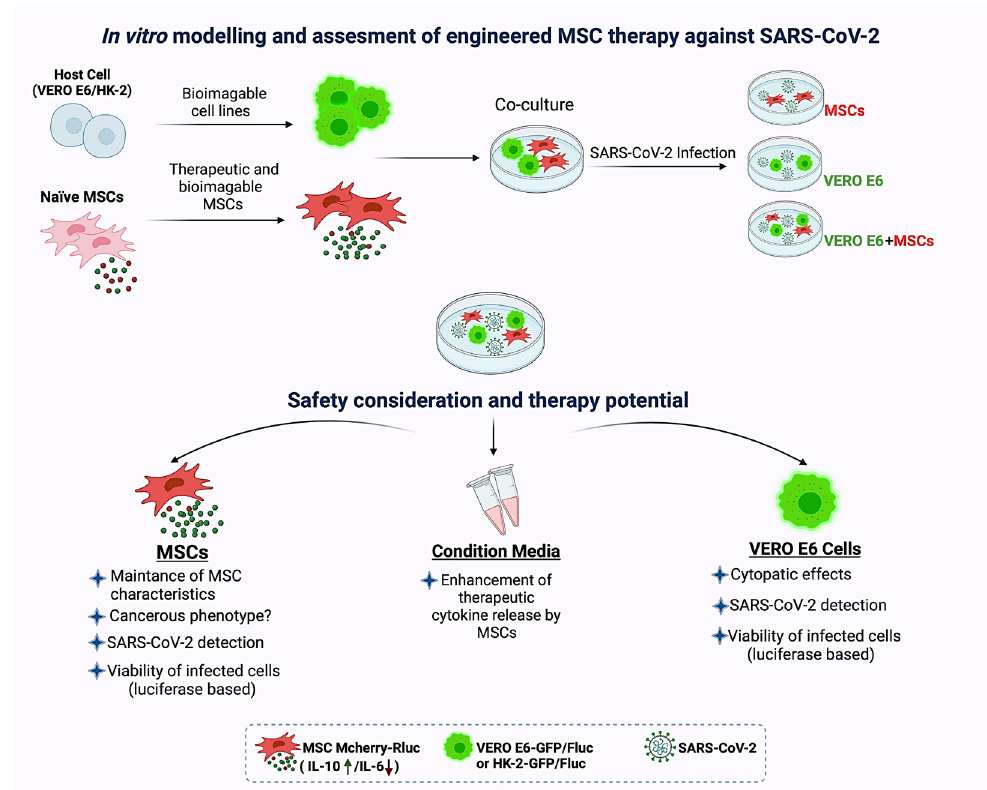
Figure 2. In vitro modeling and assessment of engineered MSC therapy against SARS-CoV-2. Co- culture of therapeutically engineered MSCs and bioimageable host cells (VERO E6 or HK-2 cells). Groups: includes MSC only, host cells only (VERO E6/HK-2) and their co-cultures (MSC+VERO E6/HK-2). All of these groups can be infected by SARS-CoV-2, while the control groups remain un- affected. MSCs in co-cultures with exposure to SARS-CoV-2 can be examined for their safety and therapeutic potential. For this, MSCs in co-culture can be evaluated for their (1) MSC-specific char- acteristics (expression of surface markers, capacity of mesodermal differentiation and plasticity abil- ities), (2) risks of cancerogenic phenotype (such as expressing cancer stem cell markers, forming